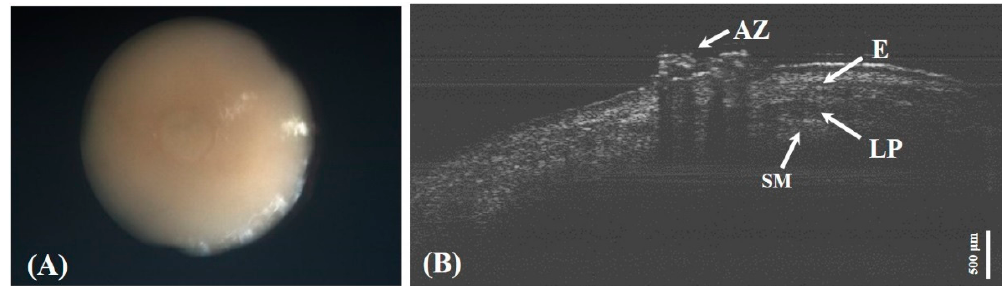
Figure 5. ( A ) White light laryngoscope image after laser ablation and ( B ) OCT image after laser ablation.